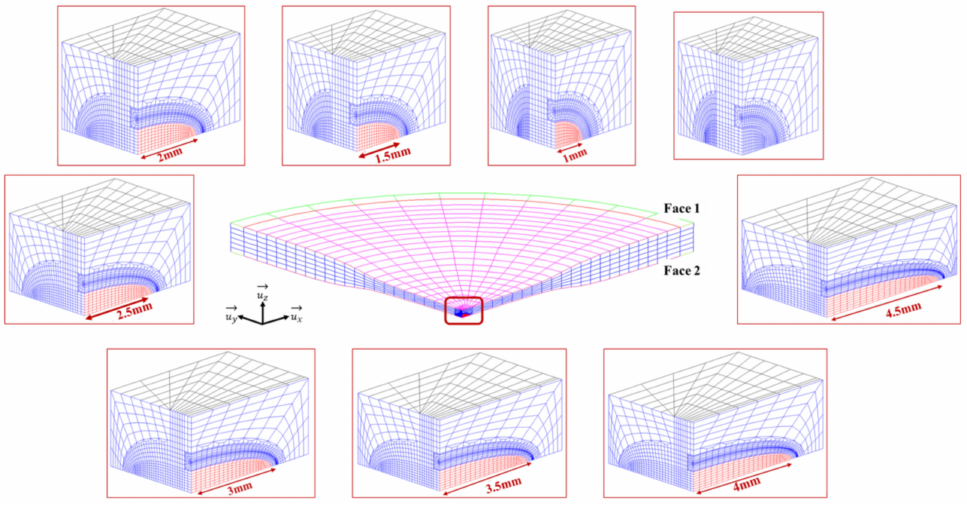
Figure 10. Mesh of the numerical model used for different crack sizes. From the results obtained, the stress normal to the plane containing the crack could be extracted and the decrease of this stress with the size of the crack could be determined. The results for two loading levels are shown in the following figure (see Figure 11). Thus, for a surface crack size of 5 mm, the applied stress decreased by